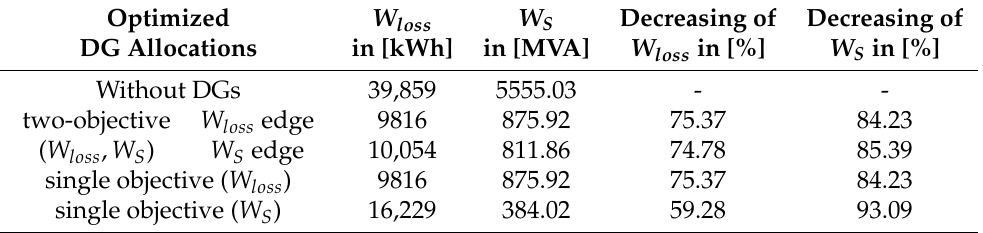
Table 5. Results for optimal solutions of Opt 2 optimization model for different objective functions (W1 workflow).